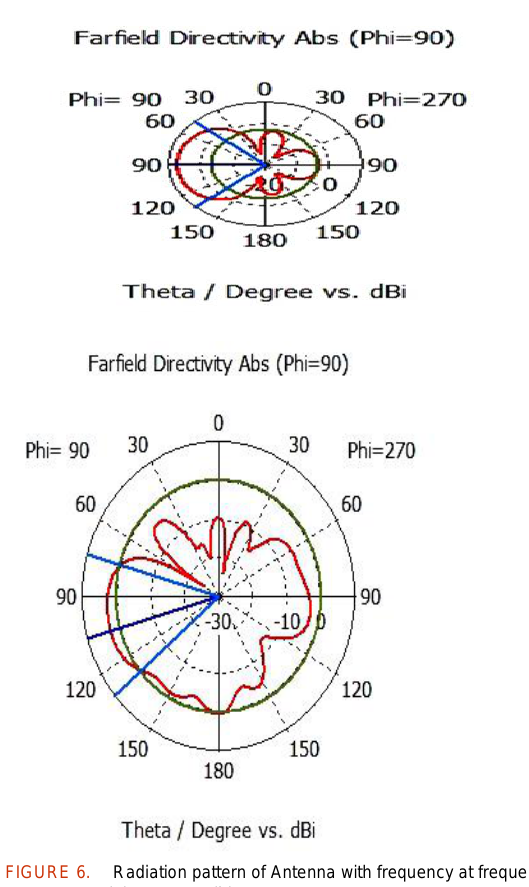
FIGURE 6. Radiation pattern of Antenna with frequency at frequency (a) 3.2 GHz (b) 4.5 GHz